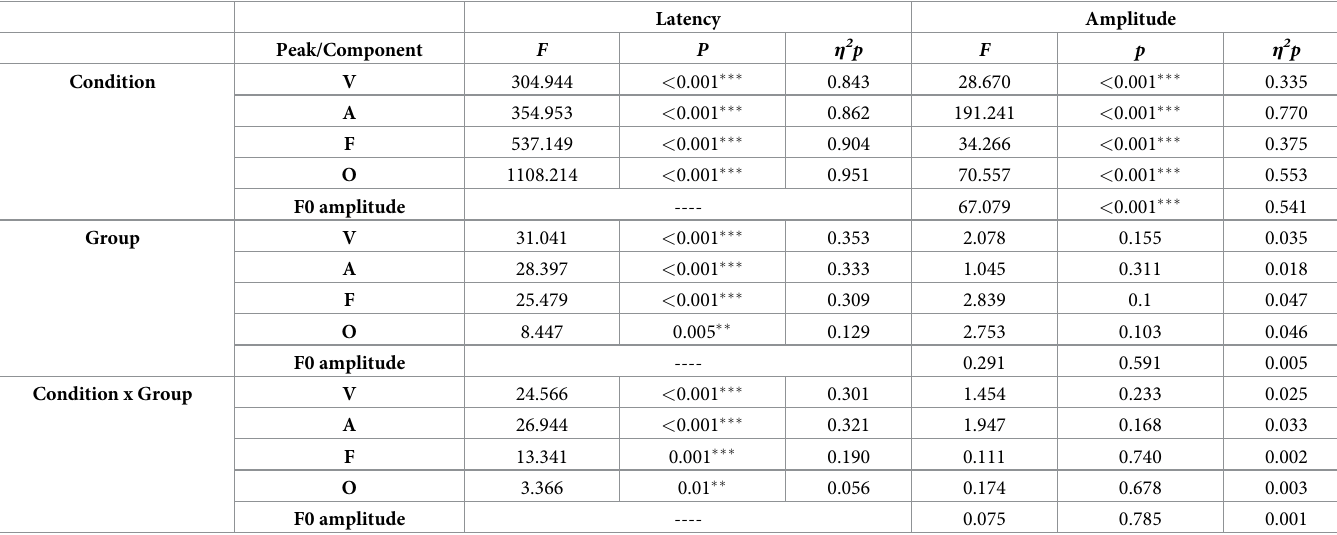
Table 1. Effects of condition and